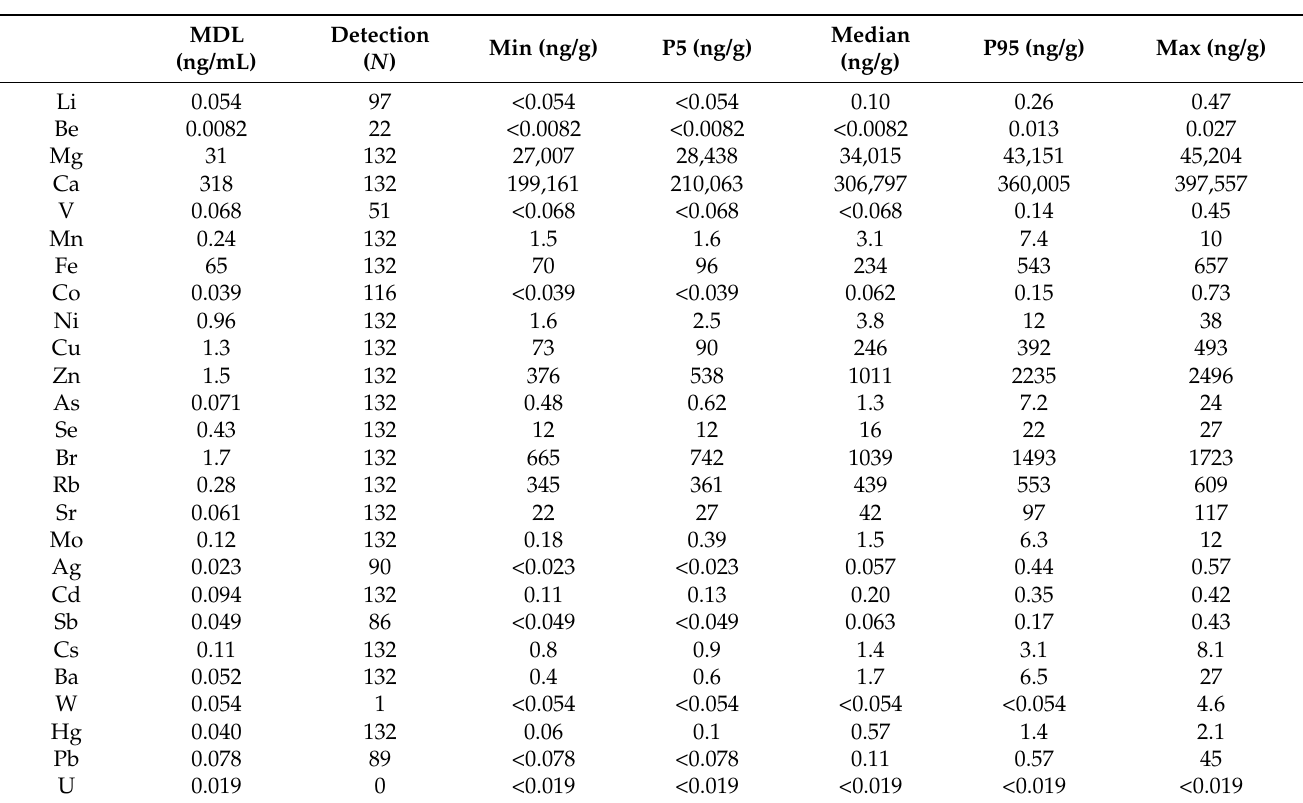
Table 4. Concentrations of 27 elements in human breast milk ( N = 132).